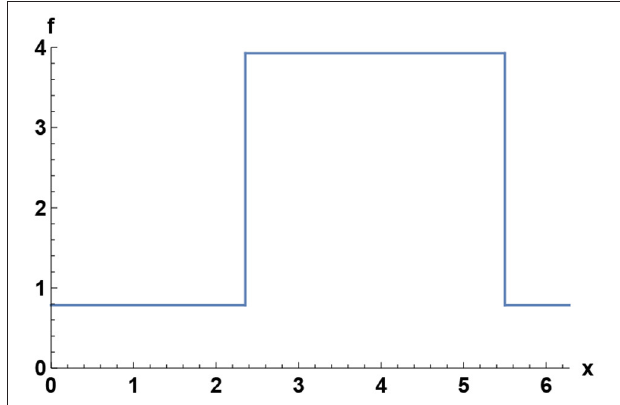
FIGURE 6 | The function f = ¯ f 0 ( x ). We take a singular matrix for M 1